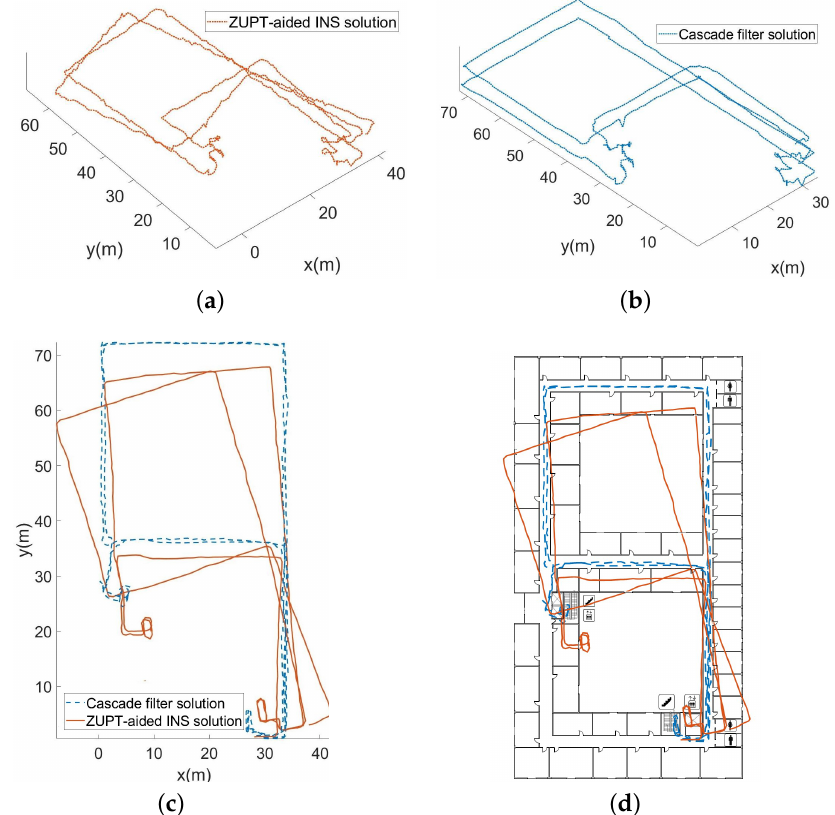
Figure 11. Three-dimensional trajectory restoration and corresponding planar projection. ( a ) 3D trajectory before correction. ( b ) 3D trajectory after correction. ( c ) Plan projection of 3D trajectory. ( d ) Plan projection of 3D trajectory with map